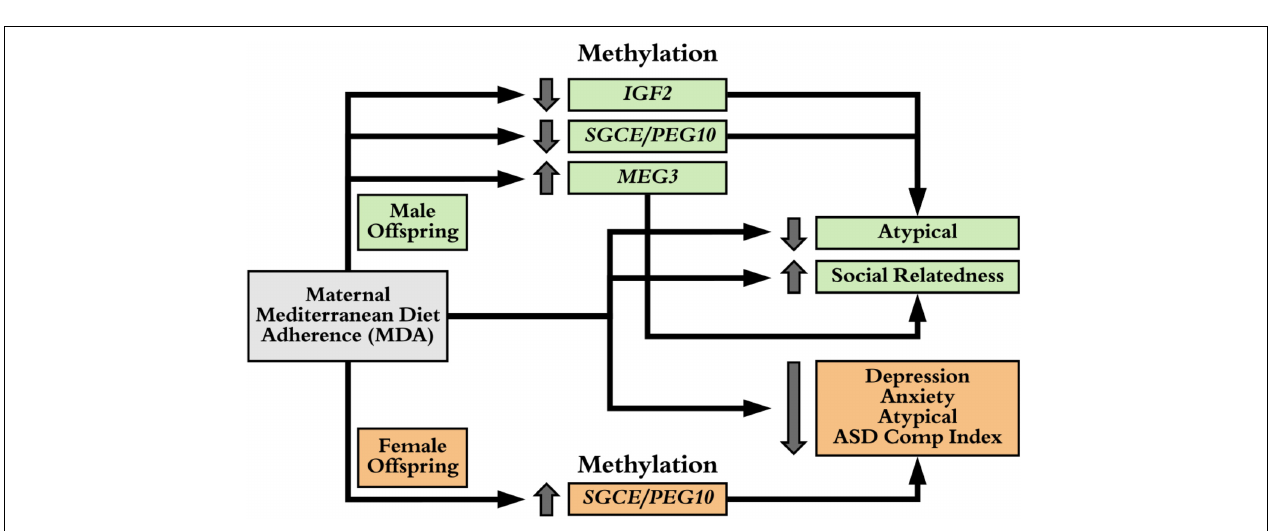
FIGURE 3 | Sex Specific Maternal MDA and CpG Associations on Child Behavior. In females (orange), maternal MDA is associated with increased methylation in the control region of SGCE/PEG10 locus. In turn, this is associated with decreased odds of depression, anxiety, atypical, and Autism Spectrum Disorder (ASD) composite index behaviors, as is maternal MDA. In males (green), maternal MDA is associated with hypo-methylation of the control region of IGF2 and SGCE/PEG10 loci and hyper-methylation of the MEG3 control region which are, in turn, are consistently associated with maternal MDA associations on atypical and social relatedness